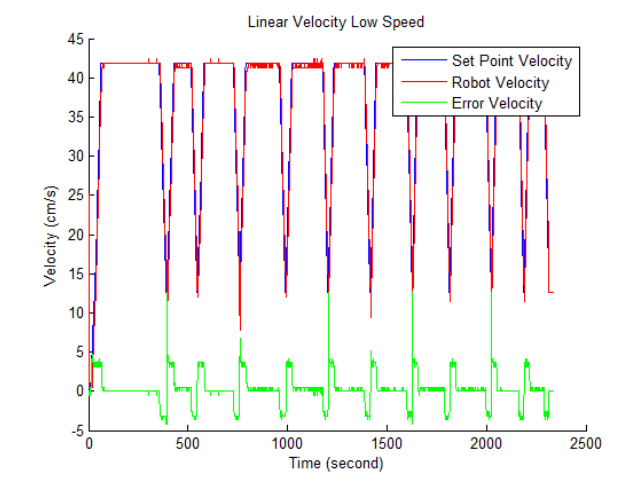
Figure 22. Low-speed Performance in Linear Velocity.